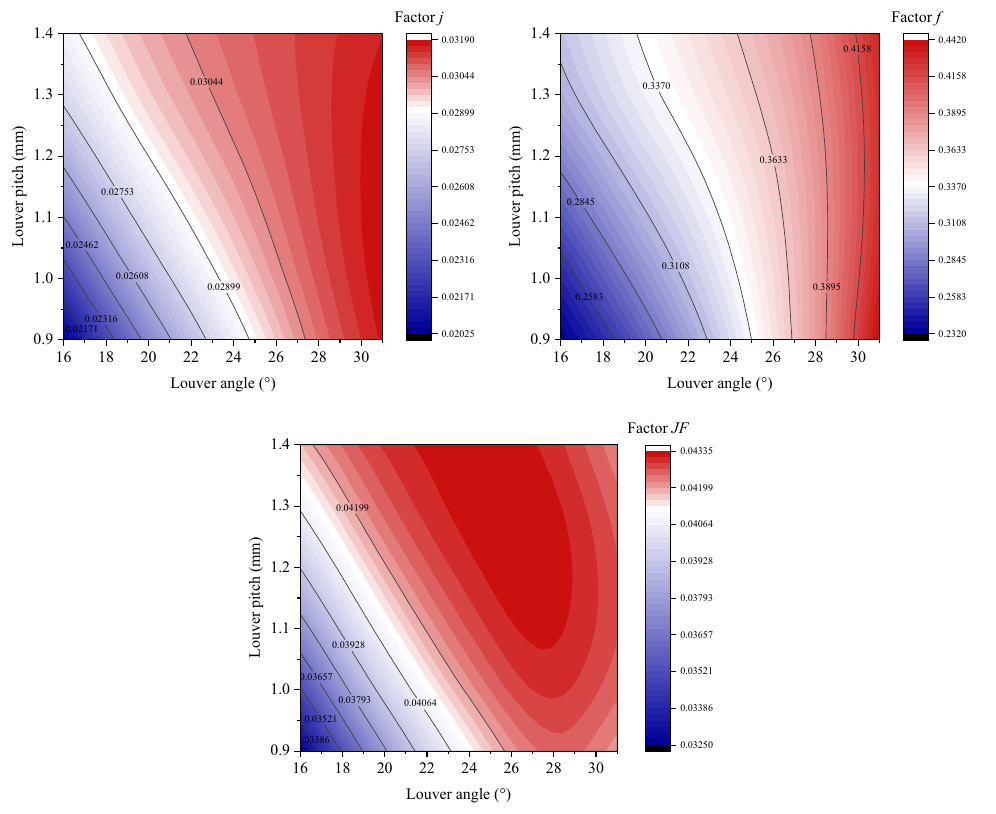
Figure 16 Change trend of j, f and JF factors when fin length is 1.05